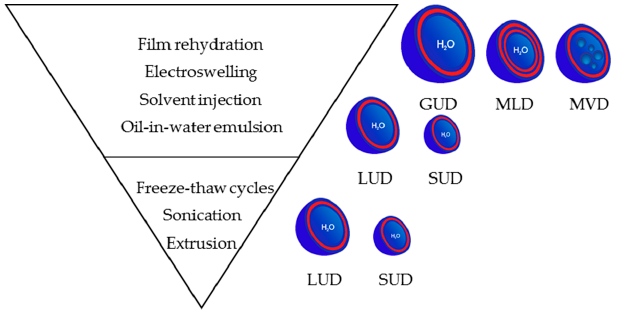
Figure 7. Overview of the different methods and post-preparation treatments for generating dendrimersomes of different sizes and lamellarity. dendrimersomes of different sizes and